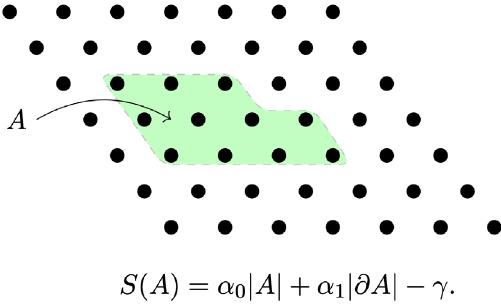
FIG. 2. Entanglement entropy of a simply connected